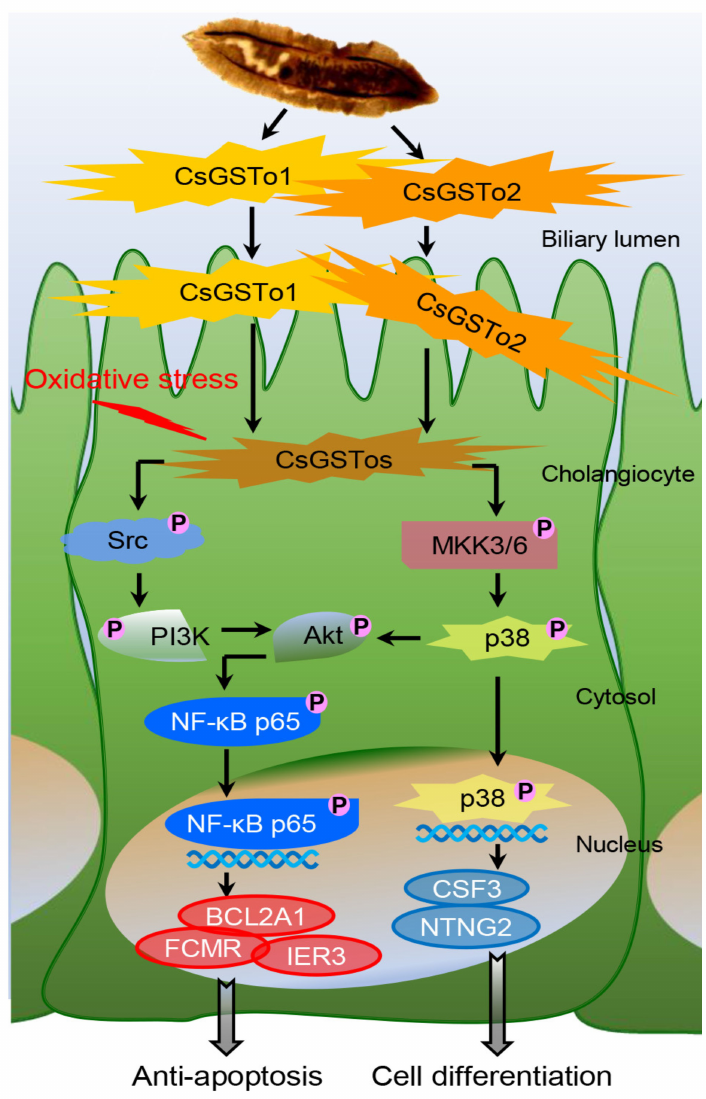
Figure 6. CsGSTo-mediated novel pathways for survival and differentiation of cholangiocyte in response to oxidative stress. CsGSTos excreted from C. sinensis were released into the biliary ductal lumen and then absorbed into the host cholangiocytes. When cholangiocytes are triggered by stress, CsGSTos activated upstream Src and downstream PI3K/Akt and NF- κ B p65 molecules. Phosphorylated NF- κ B p65 translocated into the nucleus and modulated expression of genes involved in apoptotic process. CsGSTos also increased phosphorylation of MKK3/6 followed by p38 MAPK. Subsequent nuclear translocation of activated p38 modified expression of target mRNAs and proteins associated with cell